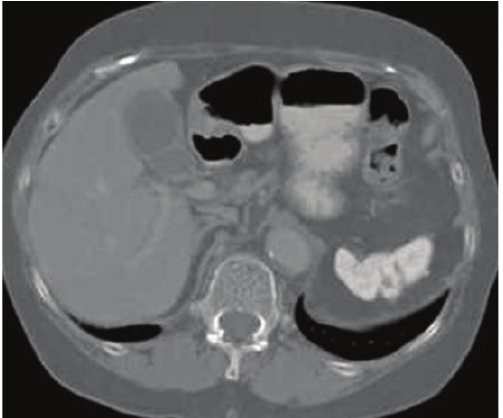
Figure 11: Axial contrast enhanced CT image at bone window demonstrates small and calcified spleen of a patient with sickle cell